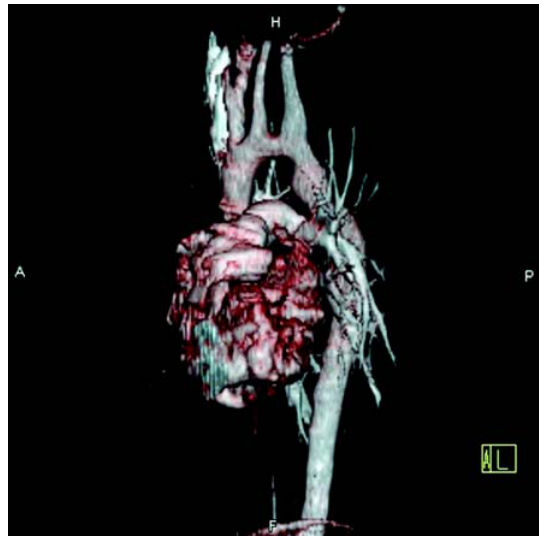
Fig. 8 – Angiotomografia torácica 18 anos após a cirurgia do paciente operado aos 8 meses de idade. Resultado excelente.